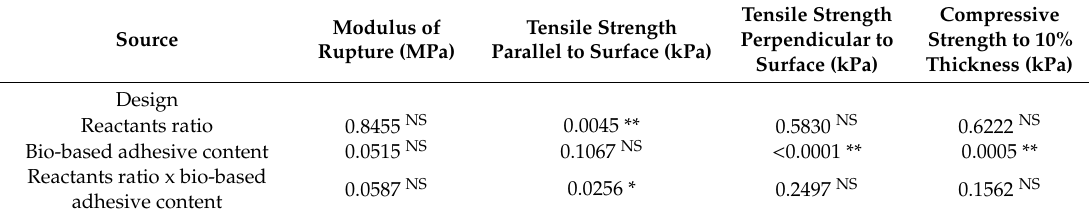
Table 6. E ff ect of parameters on the mechanical properties of insulation